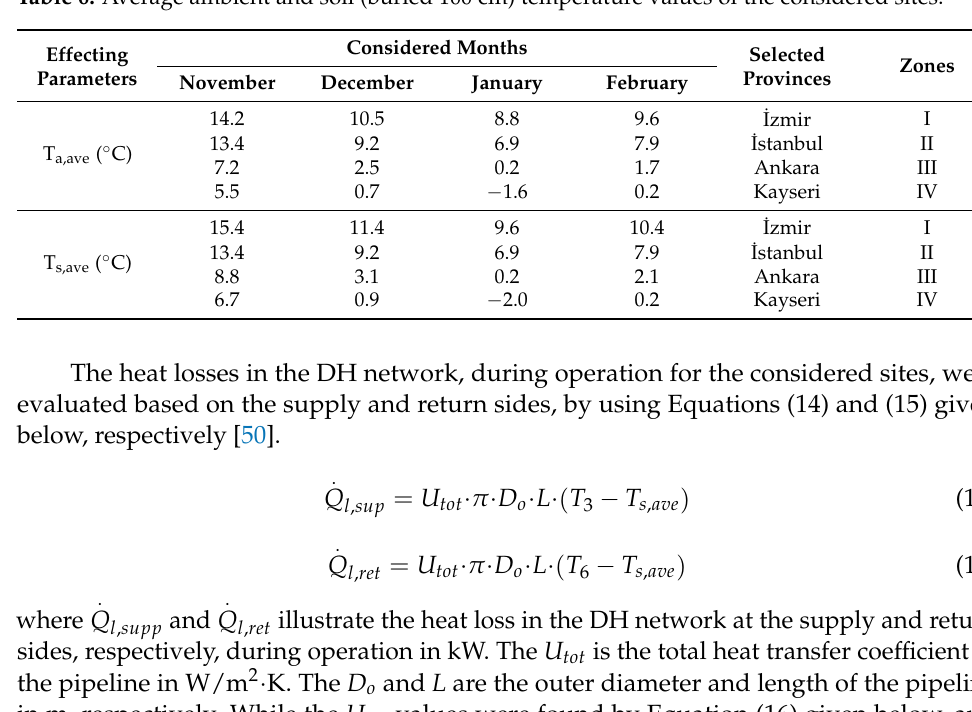
Table 6. Average ambient and soil (buried 100 cm) temperature values of the considered